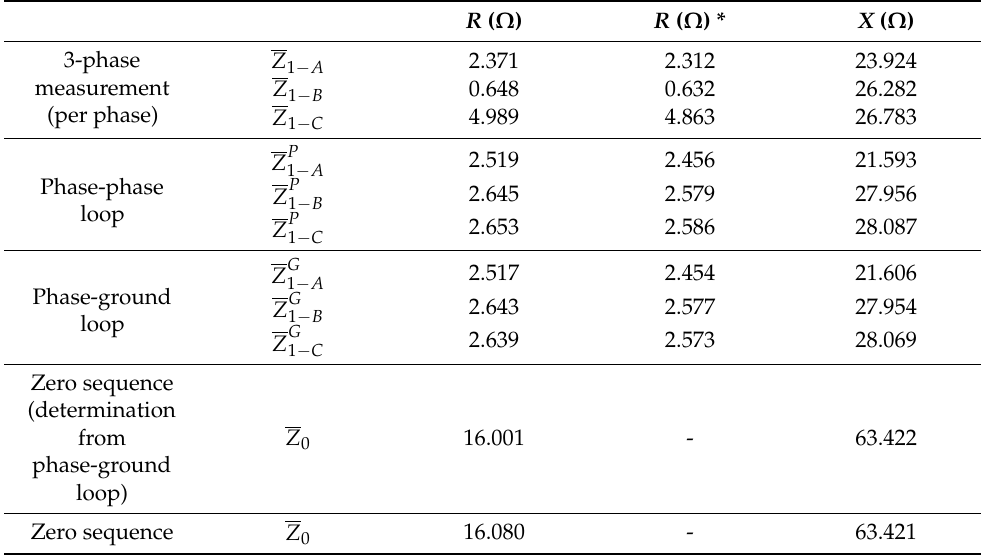
Table 4. Measurement results of symmetrical components (per phase).